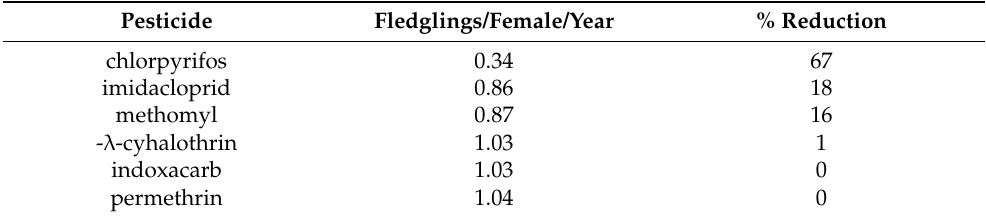
Table 4. MCnest predictions (fledglings/female/year and % reduction thereof compared to expecta- tion of 1.04 in unexposed conditions) for a single application of each of six agricultural pesticides modeled using the terrestrial investigation model to estimate